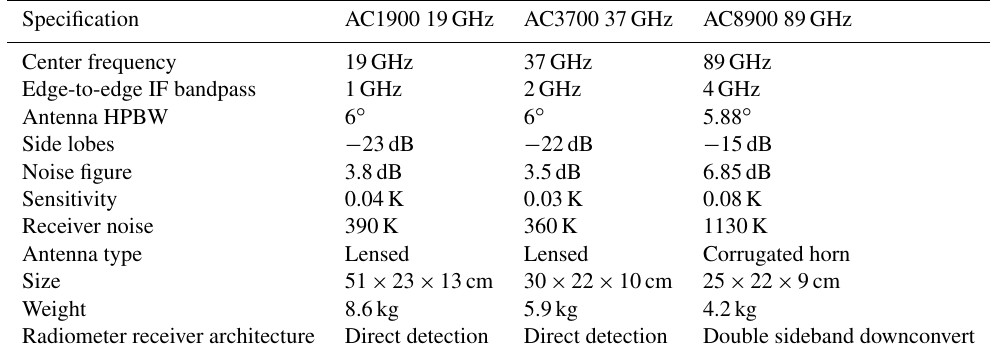
Table 2. System parameters of Radiometrics surface-based radiometer